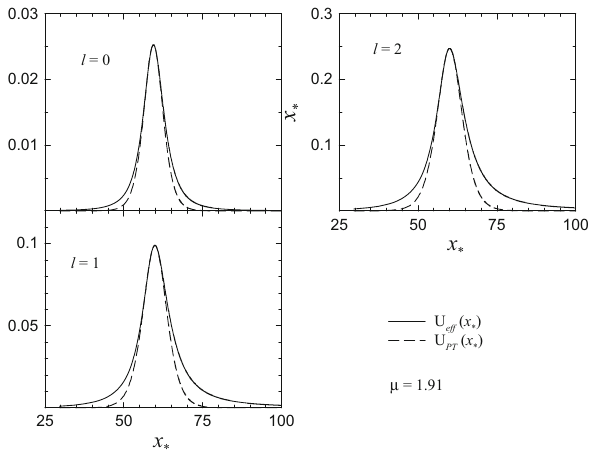
Fig. 6 Comparison of the Pöschl-Teller and actual effective potential for l = 0, 1, 2 and μ =